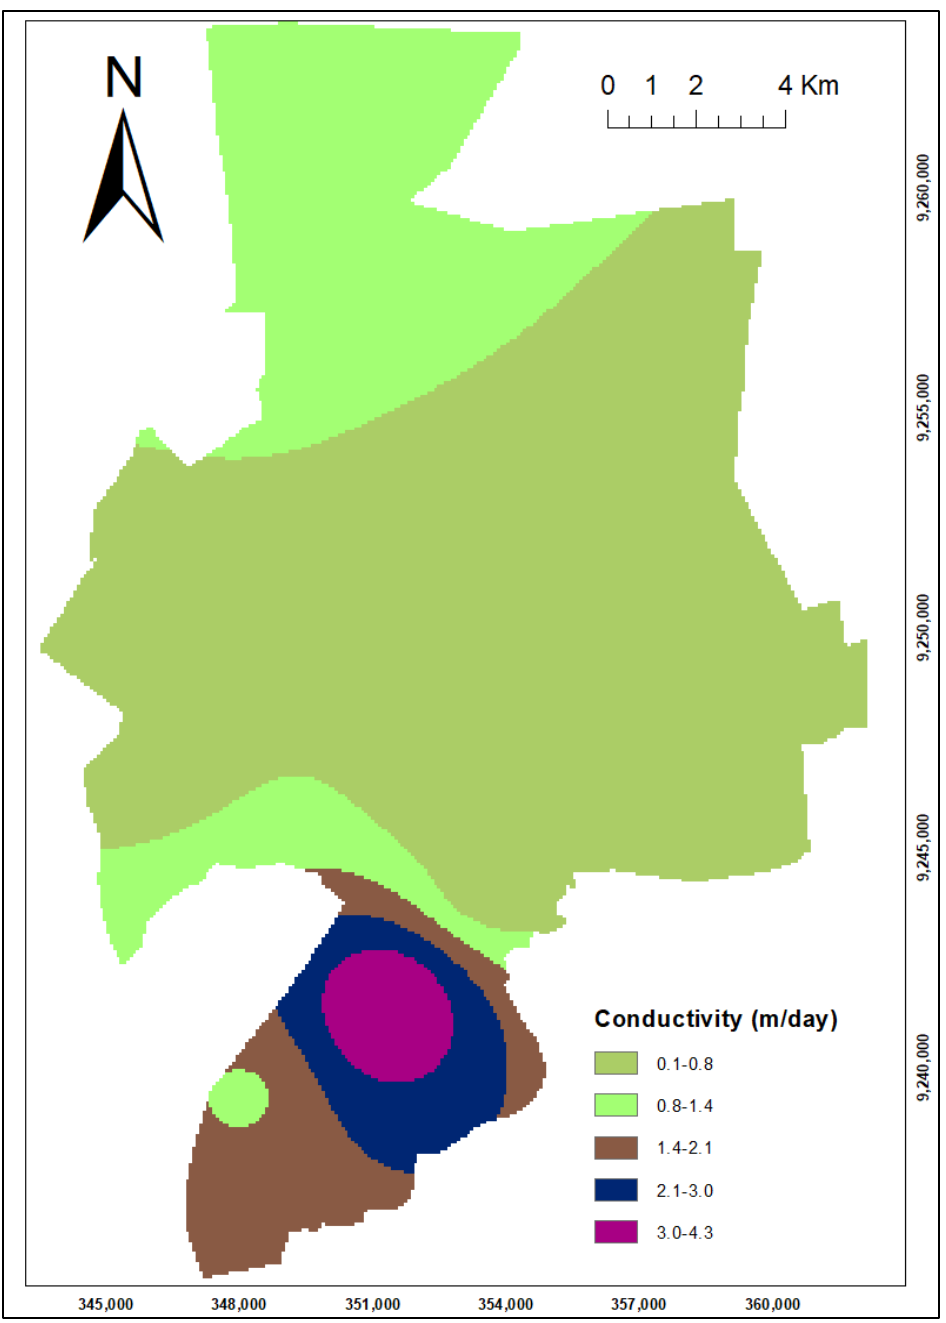
Figure 10. The hydraulic conductivity map.